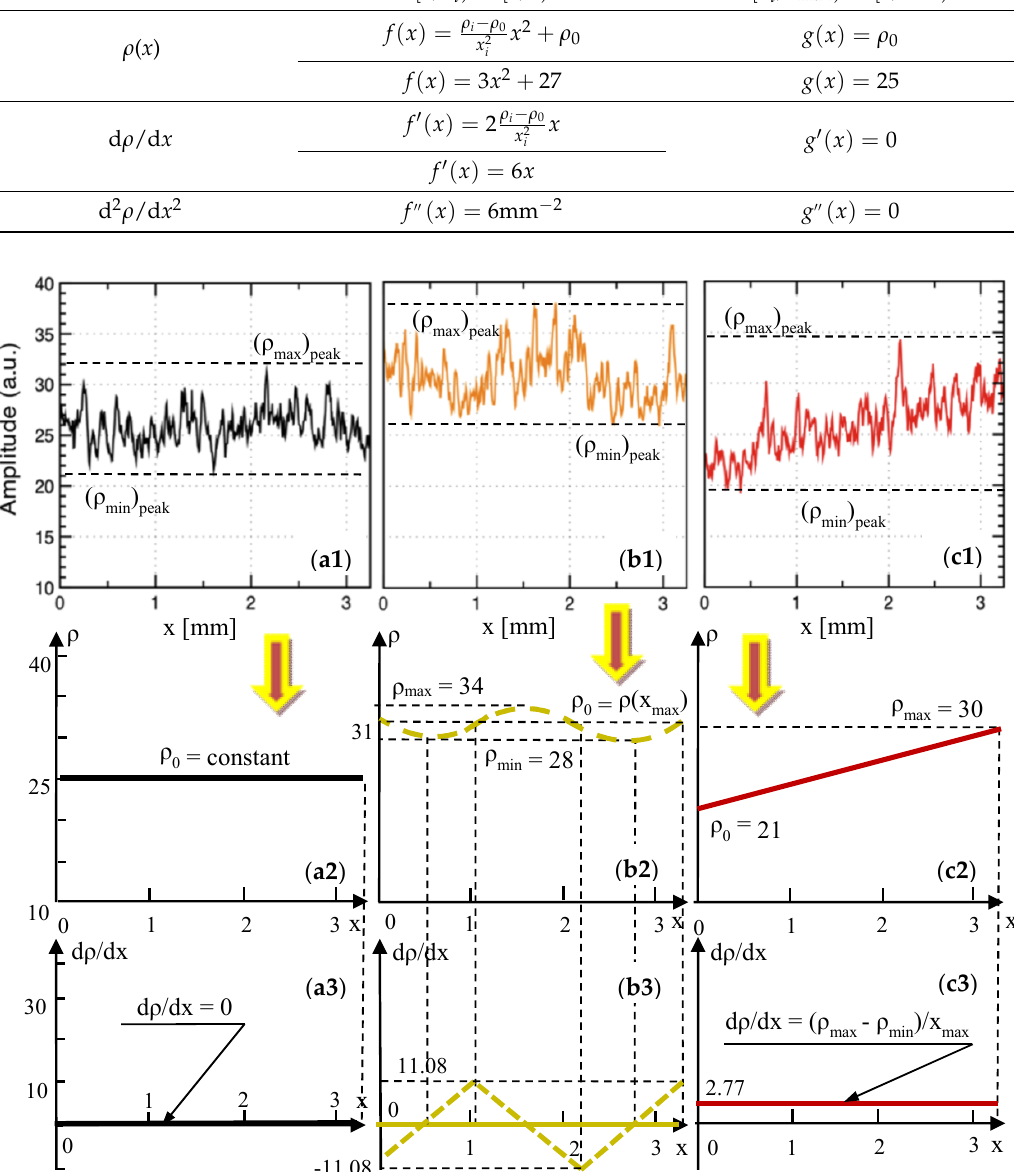
Table 5. Modeling of the reflection functions: Group L30—metal ceramic prostheses.